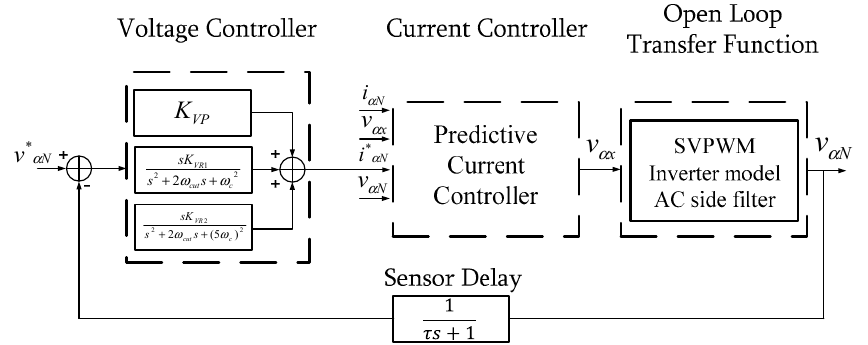
Figure 18. Schematic diagram of PR Controller with PC Controller within a VSC.